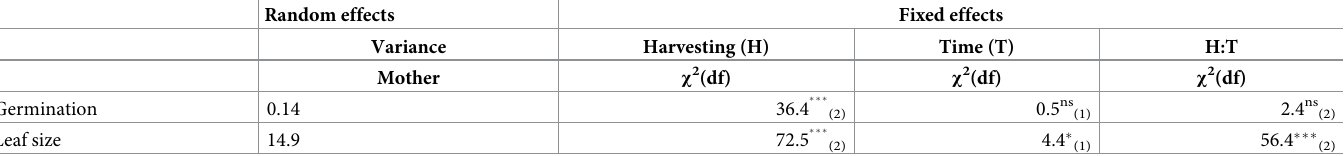
Table 3. Results of the statistical analyses on progeny traits to evaluate the effects of chronic defoliation on Brahea aculeata in the tropical dry forest of A´lamos,